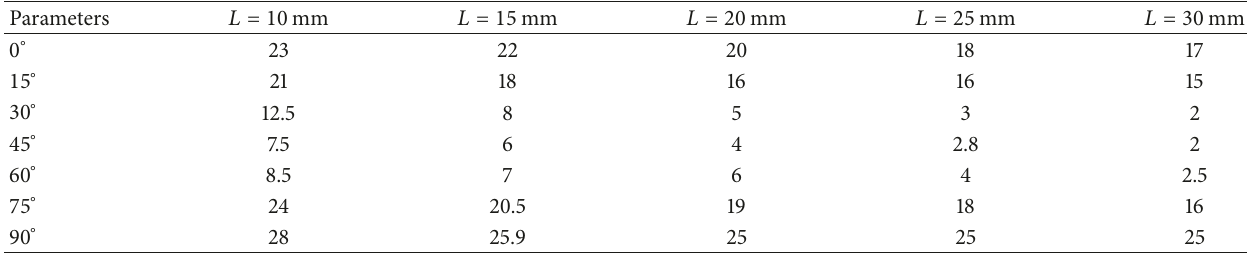
Table 3: The CI stress 𝜎 ci versus flaw inclination angle 𝛽 and length 𝐿 .